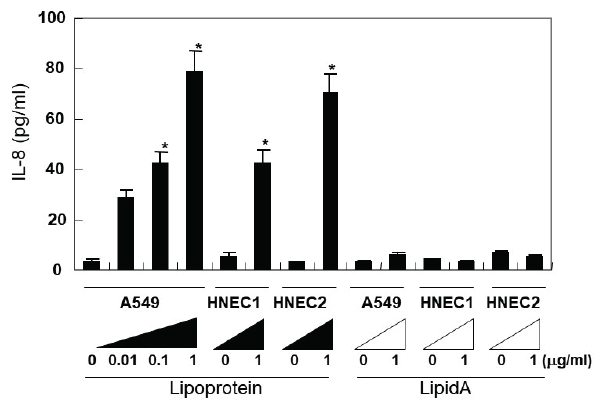
Figure 2. IL-8 release from A549, HNEC-1 and HNEC-2 cells activated with lipoprotein or lipid A. Confluent monolayers were incubated with medi- um alone (control) or stimulated with lipid A (0-1μg/ml) or lipoprotein (0.01-1μg/ml). After 24 h culture cell supernatants were harvested and analysed for IL-8 by ELISA. Values are means ± SEM from three independ- ent experiments and are expressed as nanograms per mL and 10 5 cells. *P < 0.05.